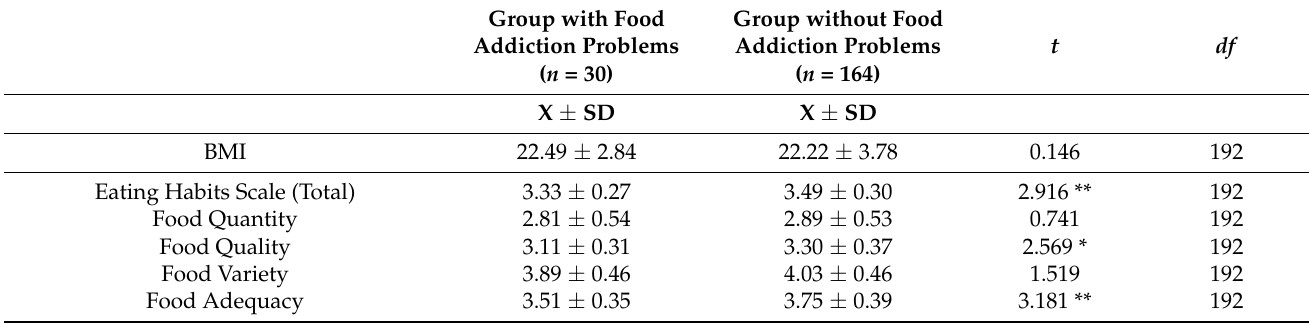
Table 2. Characterization of the group with food addiction problems and the group without food addiction problems regarding the variables under study.